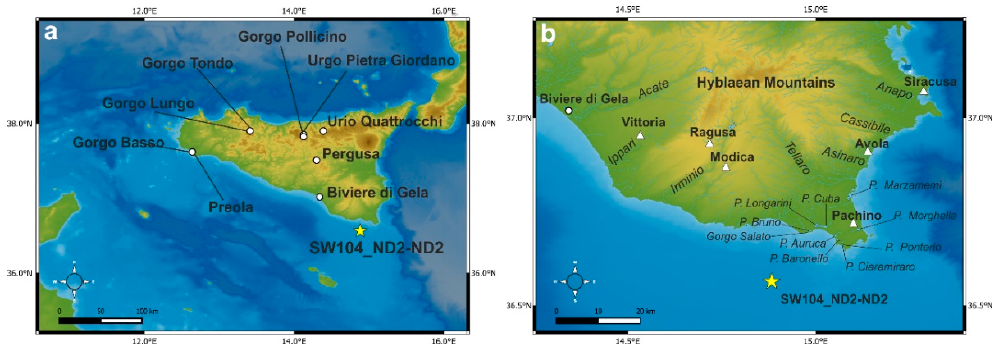
Figure 1. ( a ) Location map of the study site ND2 (yellow star) and pollen sites mentioned in the text (white dots): Biviere di Gela [11], Gorgo Basso [12], Gorgo Lungo, Gorgo Tondo, Gorgo Pollicino, Urgo Pietra Giordano [13], Urio Quattrocchi [14], Lago di Preola [15], Pergusa [16]. ( b ). Map of the study area with hydrographic grids of the main rivers and populated areas (white triangles). Map created using the free and Open Source QGIS 3.16.